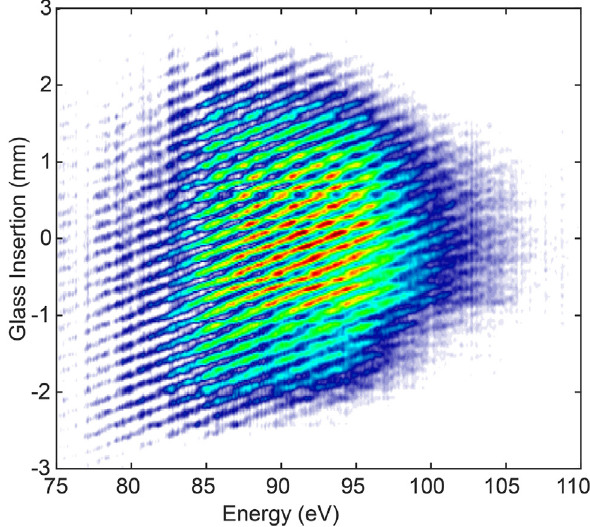
Figure 5: High-order harmonic generation (HHG) dispersion scan. Spectrogram showing the extreme ultraviolet (XUV) spectrum (vertical scale) as a function of BK7 glass insertion for HHG in neon. The spectrum is filtered by a 200 nm thick zirconium thin fi